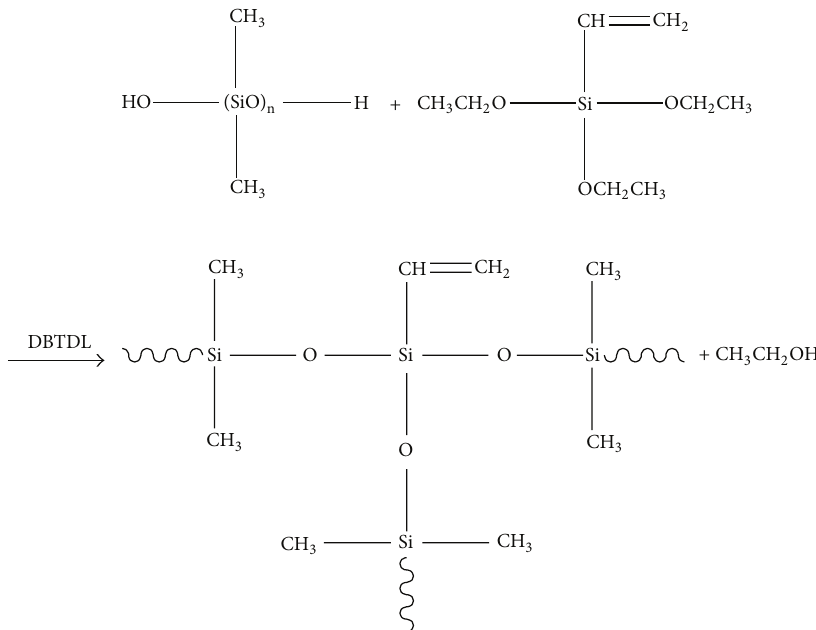
Figure 1: Preparation route of